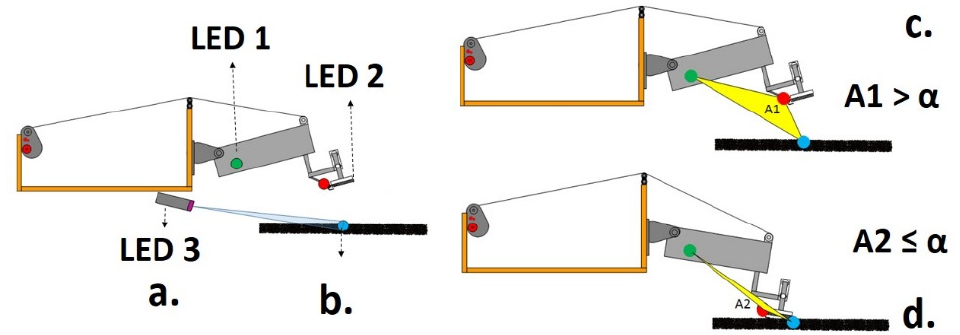
Figure 6. Markers diagram: ( a ) Marker locations; ( b ) Desired repositioning point; ( c ) Area A1; ( d ) Area A2.